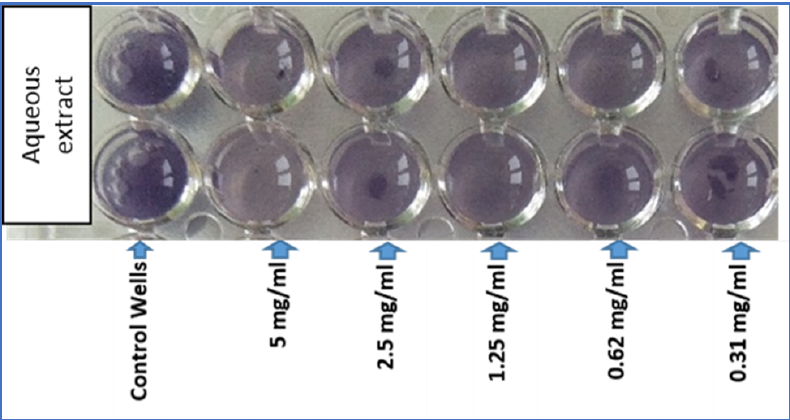
Figure 1. Qualitative method for the determination of the effect of different concentrations of A. subhirsutum aqueous extract on violacein production by C. violaceum